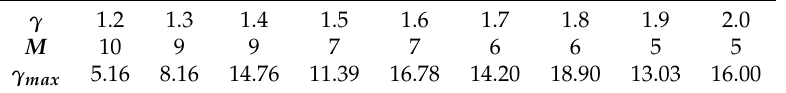
Table 2. The maximal M and corresponding equivalent maximal contention window tuning rate ( γ max ) in M -level contention window tuning algorithm for different γ ranging from 1.2 to